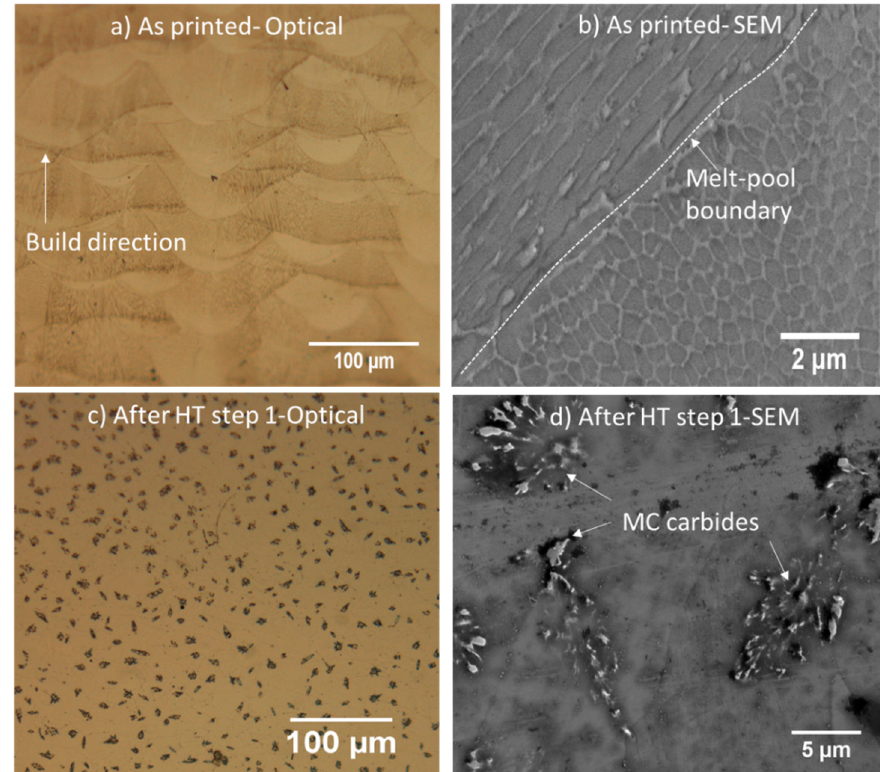
Figure 1. ( a ) Optical image of as-printed microstructure of Haynes-282, ( b ) SEM image of an as-printed microstructure of Haynes-282. The dendritic segregation is clearly seen in the SEM image. ( c ) Optical image of microstructure after solutionizing step (or heat-treatment step-1) and ( d ) SEM image of microstructure after solutionizing step.